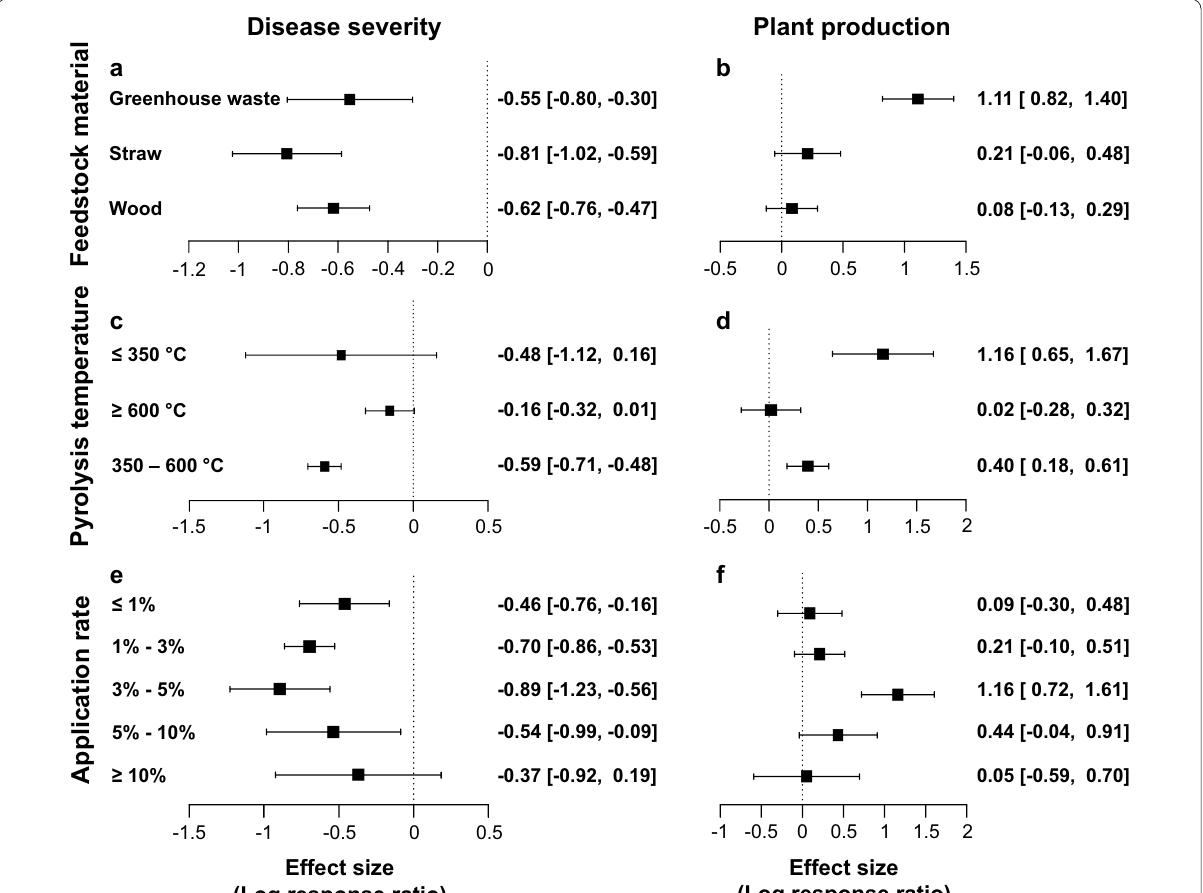
Fig. 2 Influence of biochar feedstock ( a , b ), production temperature ( c , d ), application rate ( e , f ) on plant disease suppression and plant growth,